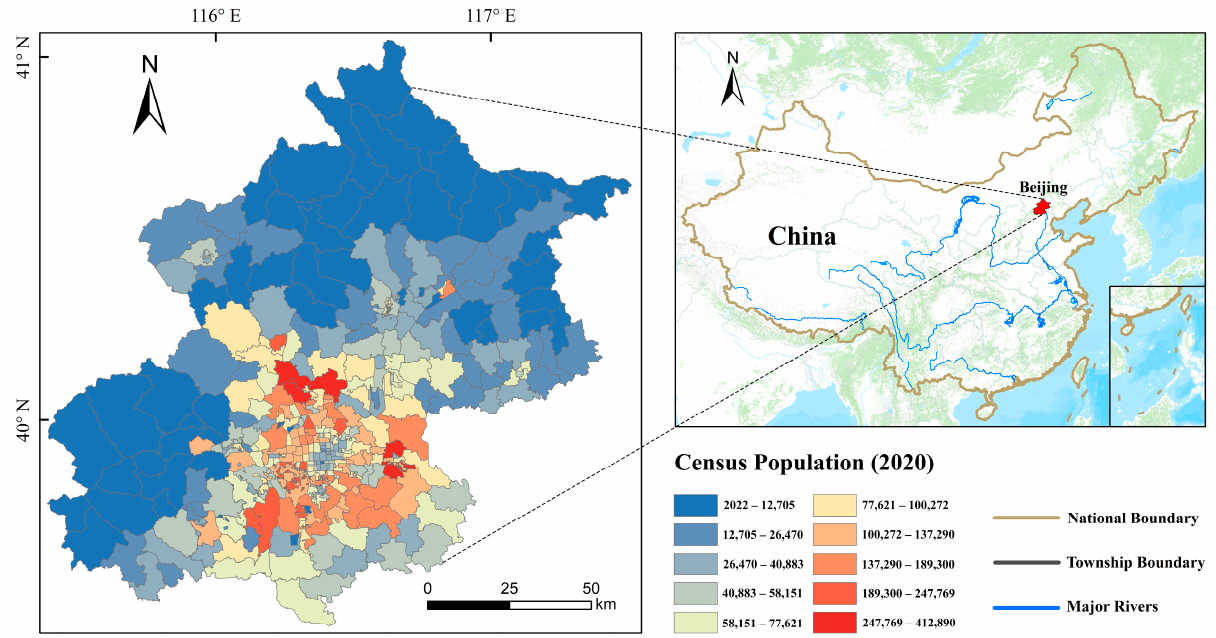
Figure 1. Geographical location and census situation of